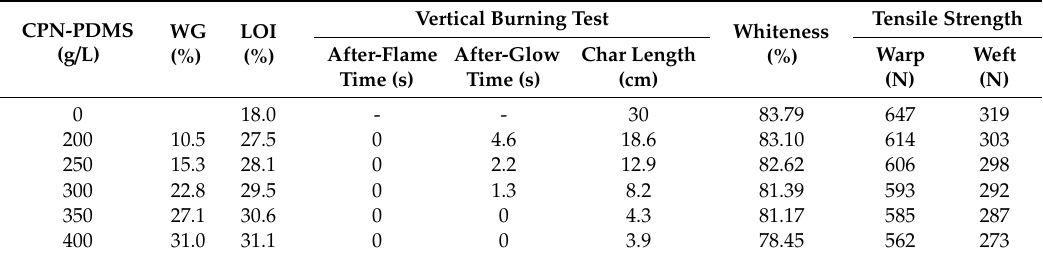
Table 1. The LOI, vertical flammability, whiteness and breaking strength analysis of treated cotton